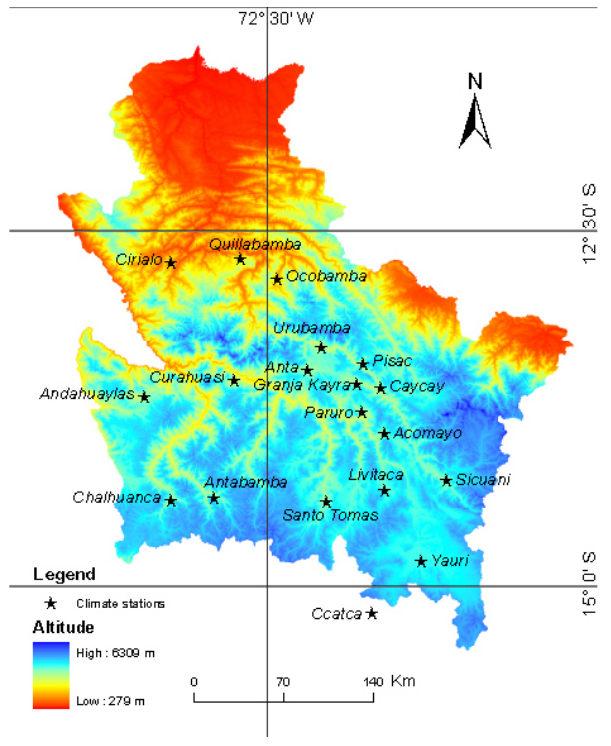
Fig. 2b. The distribution of climate stations in the Regions Cusco and Apurimac, an area with significant